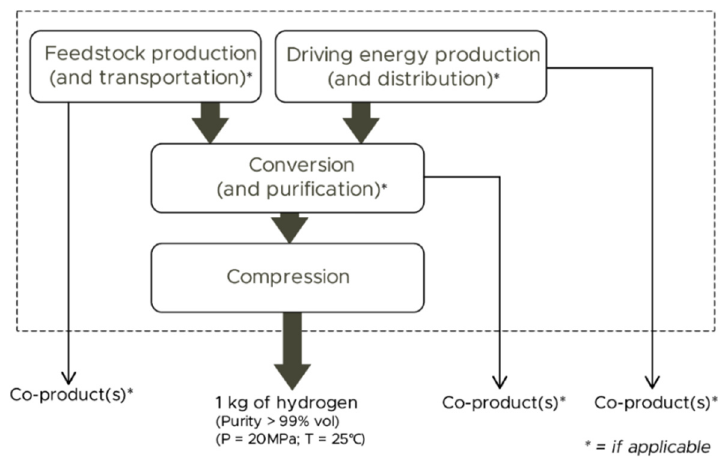
Figure 1. Harmonised hydrogen energy system.